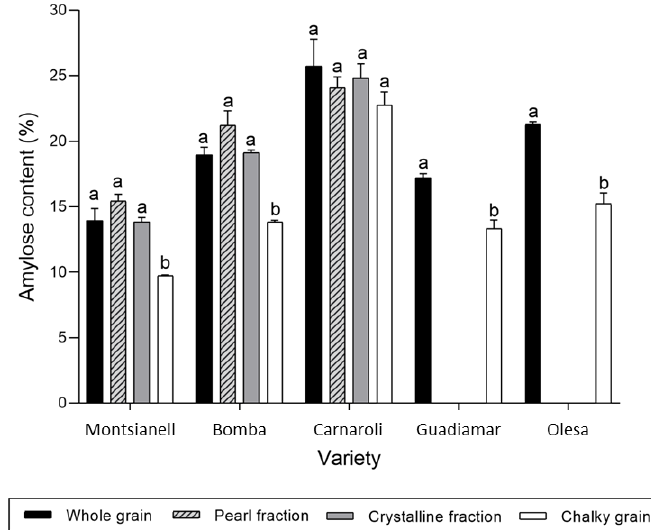
Figure 4. Percentage amylose content for each cultivar and fraction. Black bars represent the amylose content in normal perfect grains, dashed grey bars represent the content of the pearl fraction in the pearled cultivars, grey bars represent the content of the crystalline fraction in the pearled cultivars and white bars represent the content for chalky grains in all cultivars. Values are presented as mean ± SEM. Different letters within a cultivar indicate significant differences between groups ( p < 0.05).